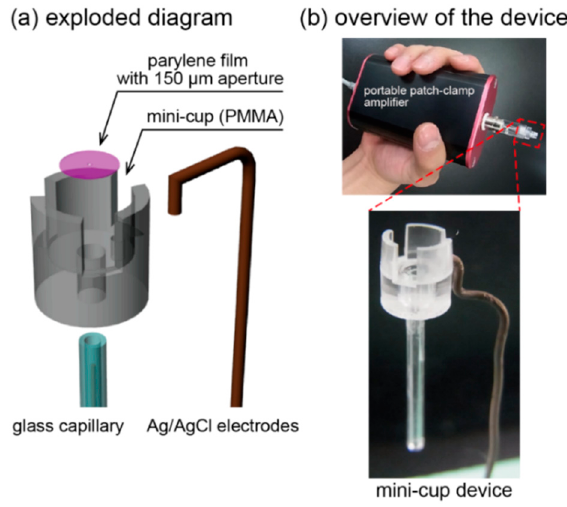
Figure 4. ( a ) Exploded diagram of the mini-cup device. ( b ) Photos of the developed device connected to a portable patch-clamp amplifier.